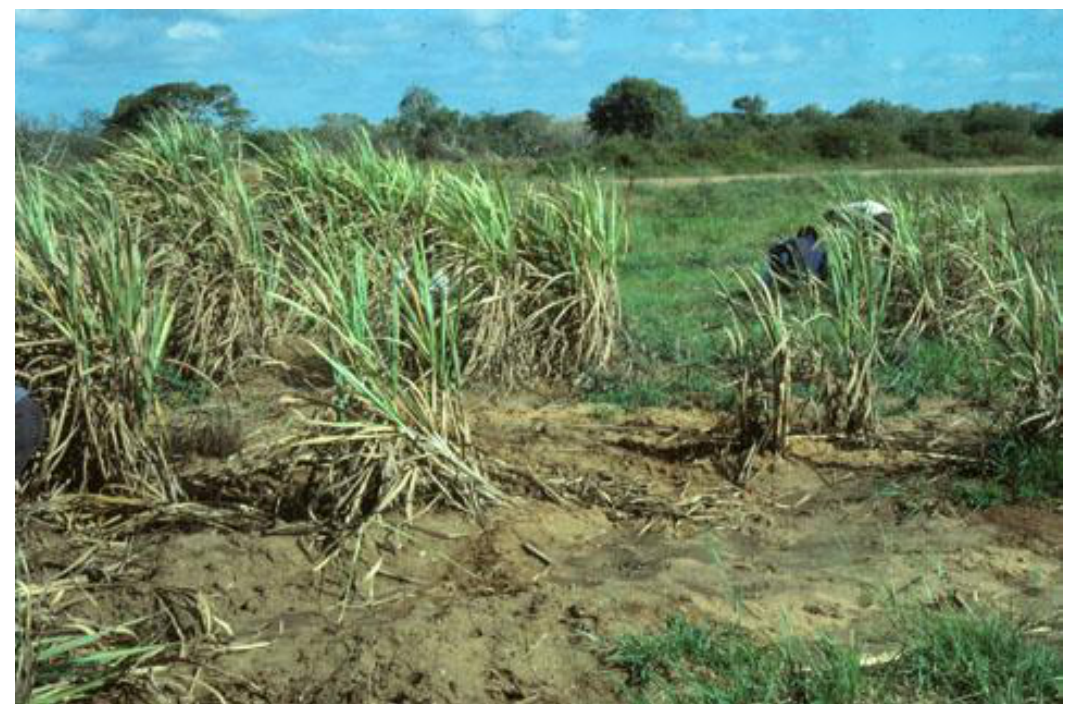
Figure 1. Damage to sugar cane associated with white grubs, Juba Sugar Project, Somalia, October 1986. Note rough grassland in the middle distance, and (cid:179) bush (cid:180) in the